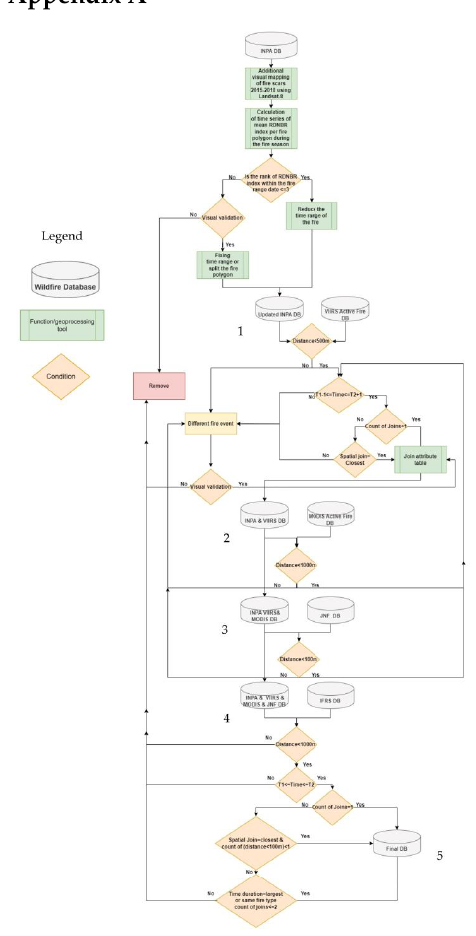
Figure A1. Flowchart of the creation process of Israel’s national wildfires